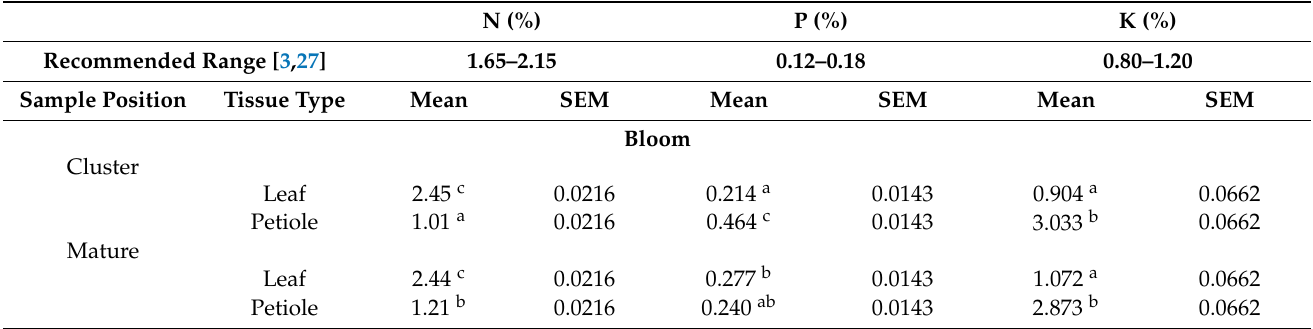
Table 1. Mean and standard error of mean (SEM) for nitrogen (N), phosphorus (P) and potassium (P) content of each position and tissue type over bloom, fruitset and v é raison (combined data from 2019 and 2020, n =